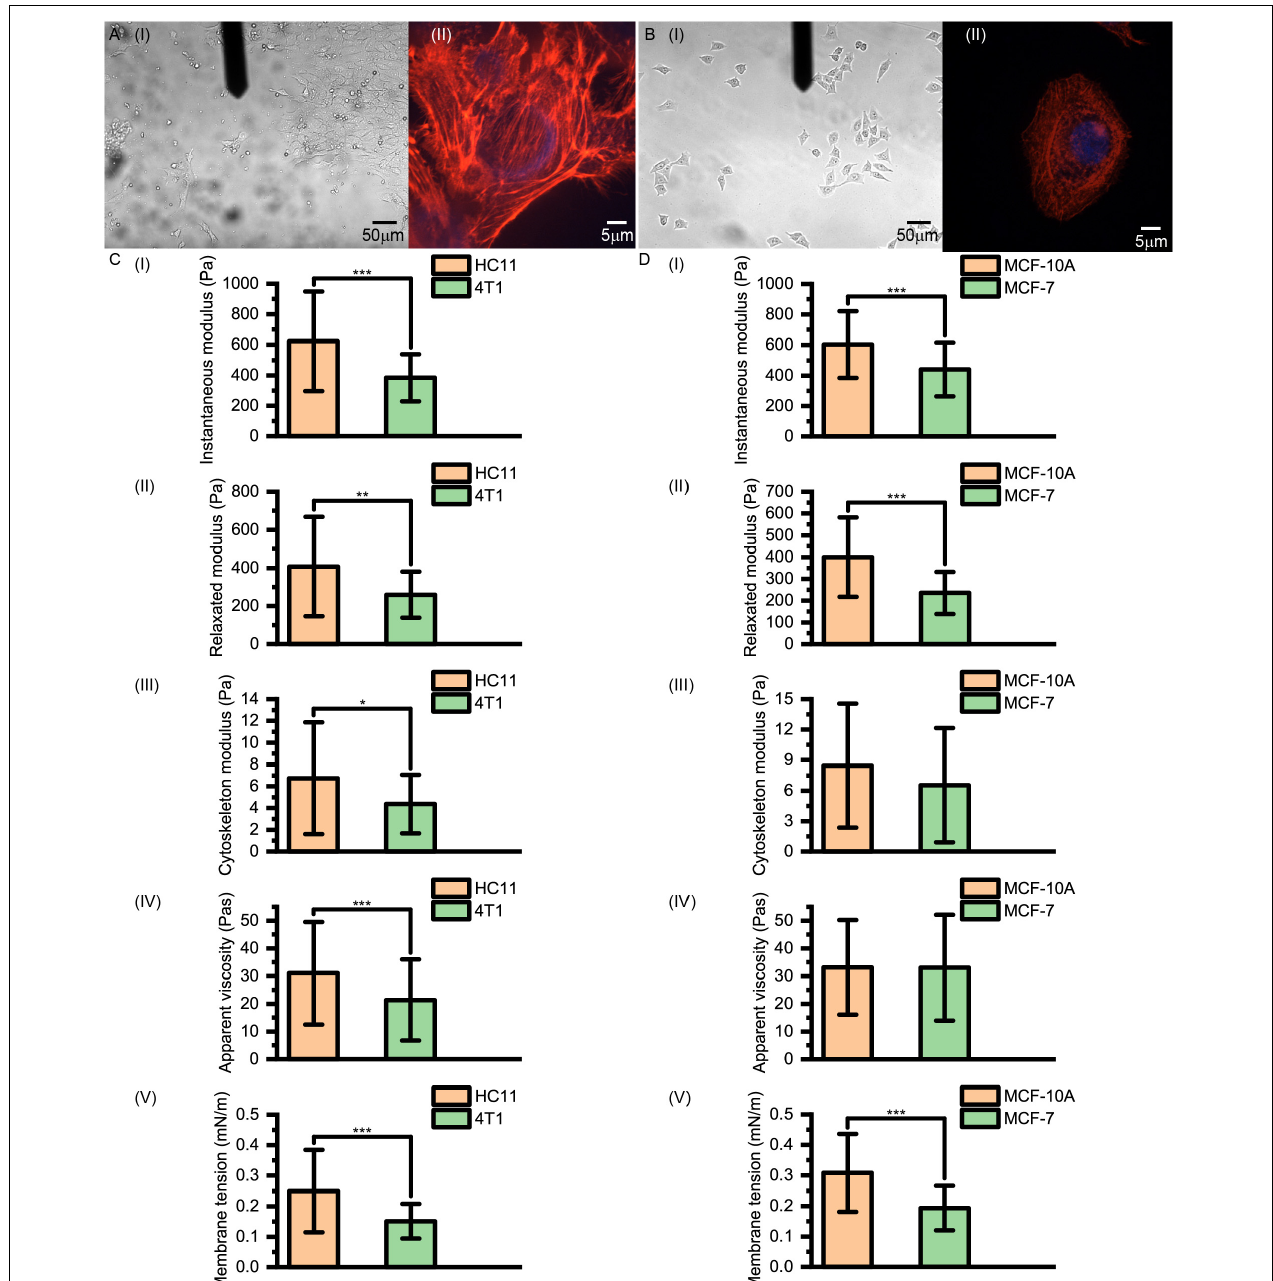
FIGURE 5 | (A) Images of 4T1 and (B) MCF-7 cells acquired using optical microscopy and confocal microscopy. (C,D) Instantaneous modulus, relaxed modulus, cytoskeleton modulus, apparent viscosity and membrane tension values of (C) murine HC11 and 4T1 cells and (D) human MCF-10A and MCF-7 cells. HC11 and MCF-10A are normal breast cells and 4T1 and MCF-7 are cancerous breast cells.